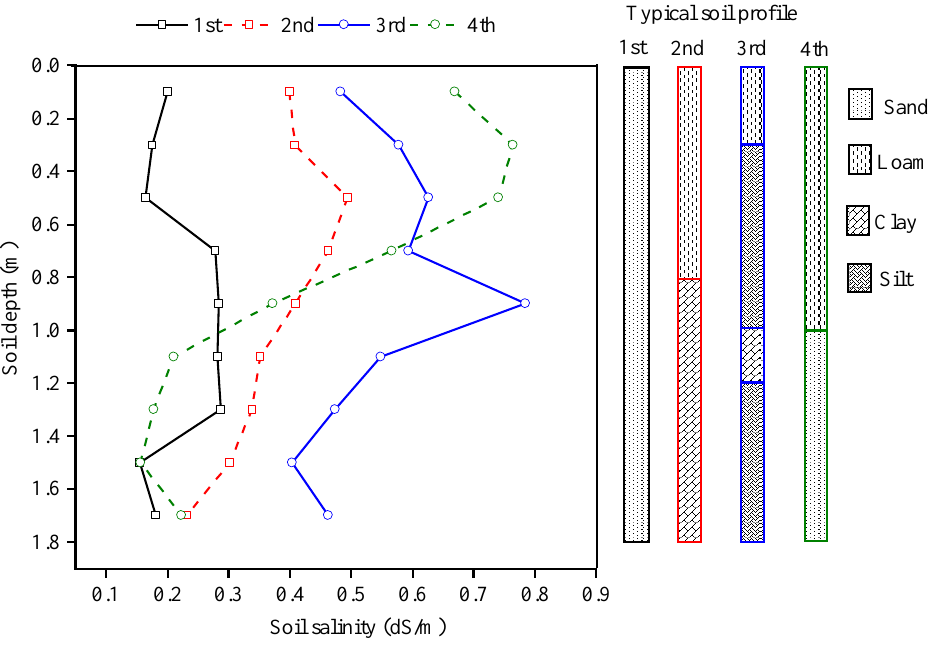
Figure 9. Soil salinity of typical soil profile.